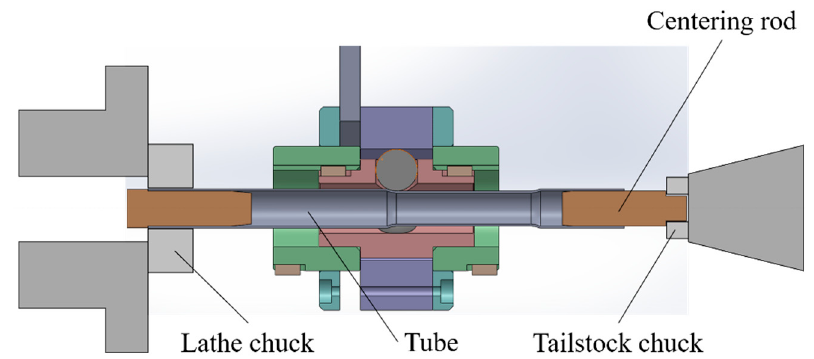
Figure 2. Schematic diagram of the experimental ball die. Table 1. Conditions of the experiment.